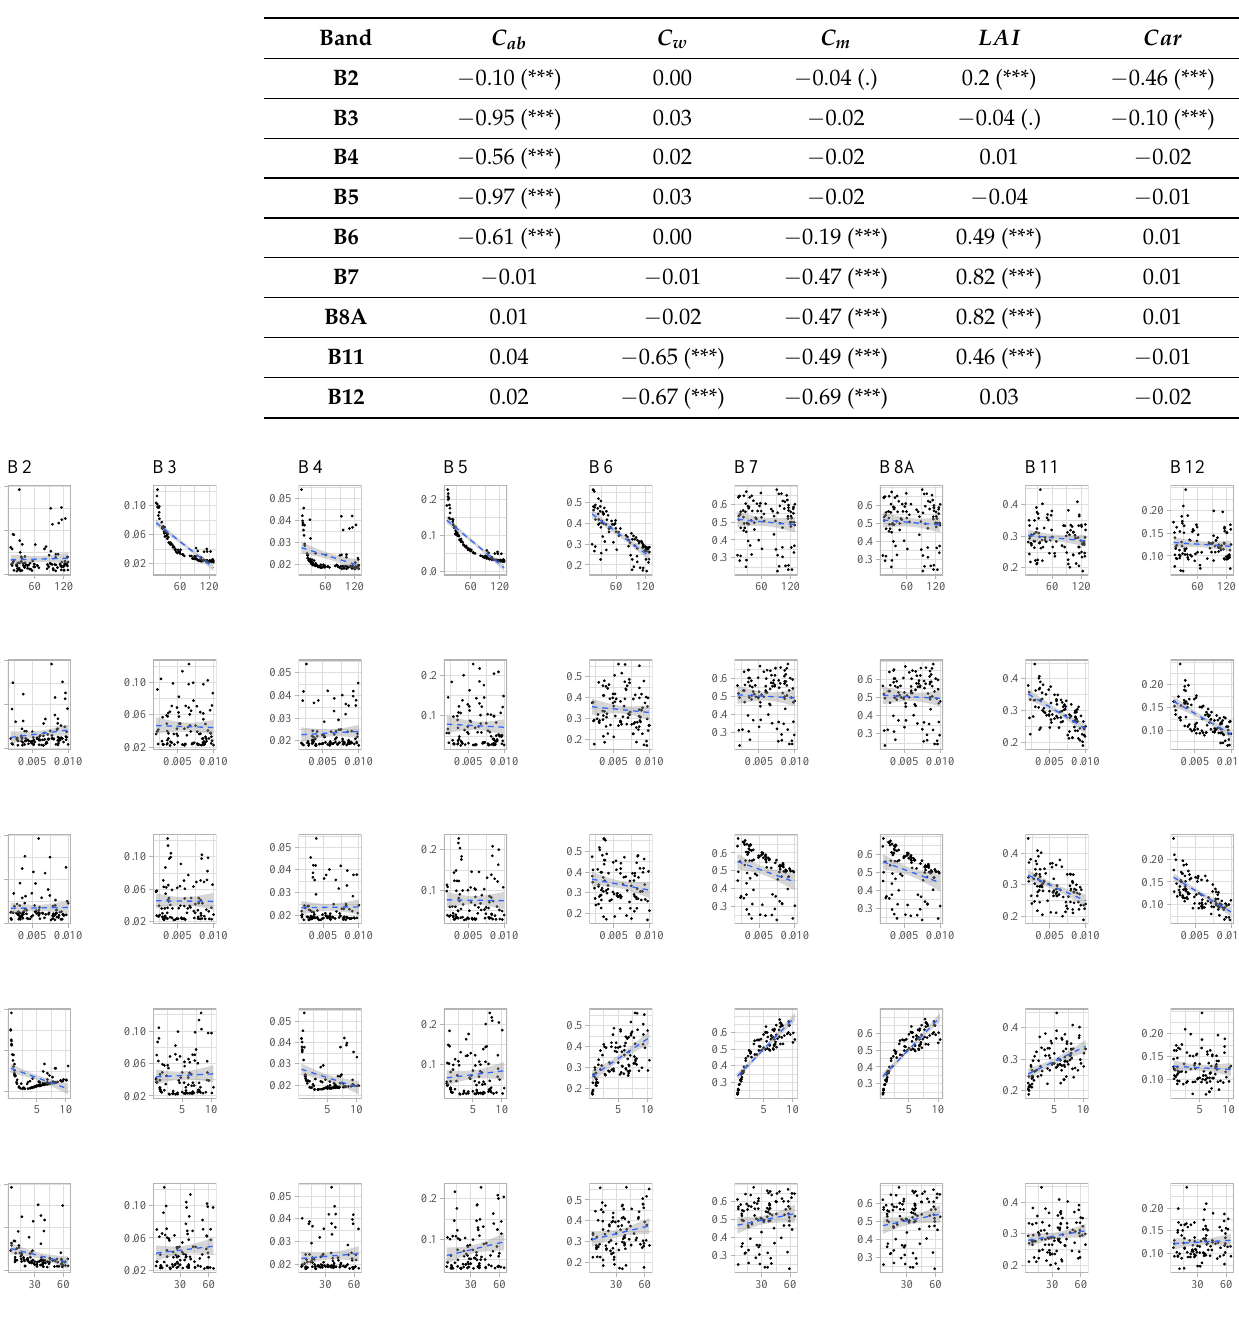
Table 3. Summary of Spearman’s ρ correlation coefficients for different biophysical variables and S2 bands. The significance levels are represented as: p ≤ 0.001 (***); p ≤ 0.01 (**); p ≤ 0.05 (*); p ≤ 0.1 (.);